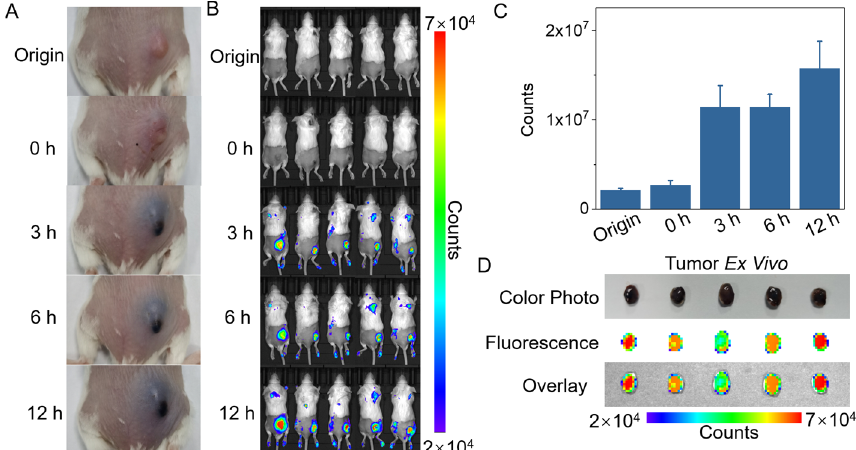
Figure 4. Time optimization of intratumoral injection of ACG hydrogel in mice. ( A ) Digital photo- graphs of tumor color change derived from the reaction of ACG hydrogel with tumor during 12 h. ( B ) In vivo imaging of tumor fluorescence signal change derived from the reaction of ACG hydrogel with tumor during 12 h. ( C ) The quantitative analysis of fluorescent counts of tumor sites in ( B ) is shown as means ± SD, n = 5. ( D ) Blue tumors exfoliated at 12 h after intratumoral injection of ACG hydrogel. Up: color digital photograph. Middle: fluorescence photo. Down: overlay of grey photo and fluorescence photo.